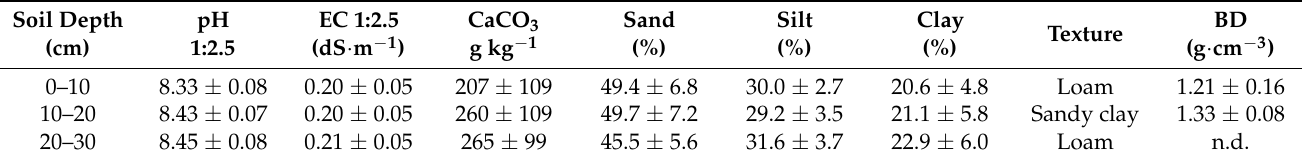
Table 1. General soil characteristics in the study site. Values are mean ± standard deviation (n = 9–12). EC: electrical conductivity; BD: bulk density. EC and pH were measured in a 1:2.5 ( w / v )